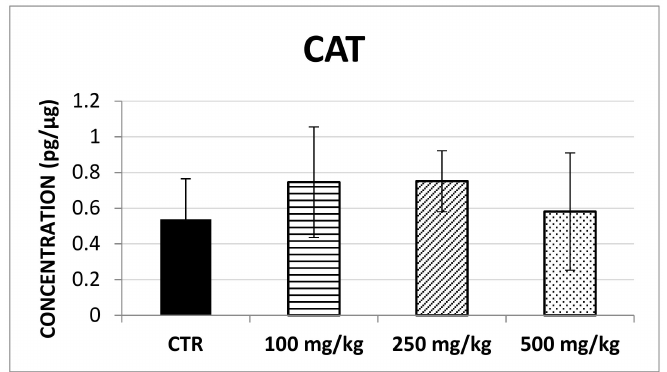
Figure 5. This histogram illustrates CAT concentration in control and treated groups. No significant differences could be found between